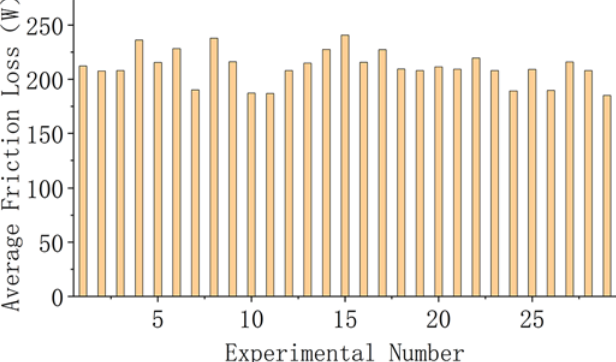
Fig. 17. Experimental scheme and calculation results.